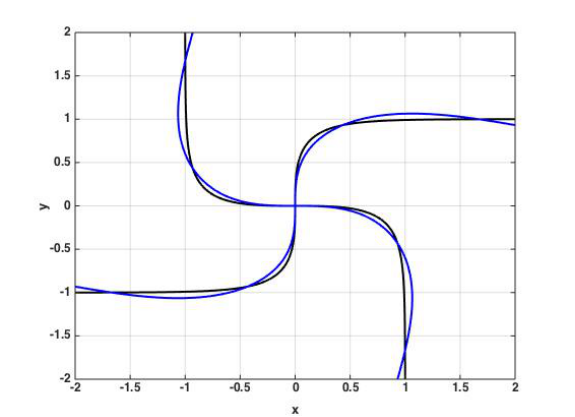
Figure 1. The nullclines. Nullclines of both Wilson–Cowan (black) and canonical (blue) models. Here a = 1, b = c = ω = 1.7, d = − 1, α = 0, β = −